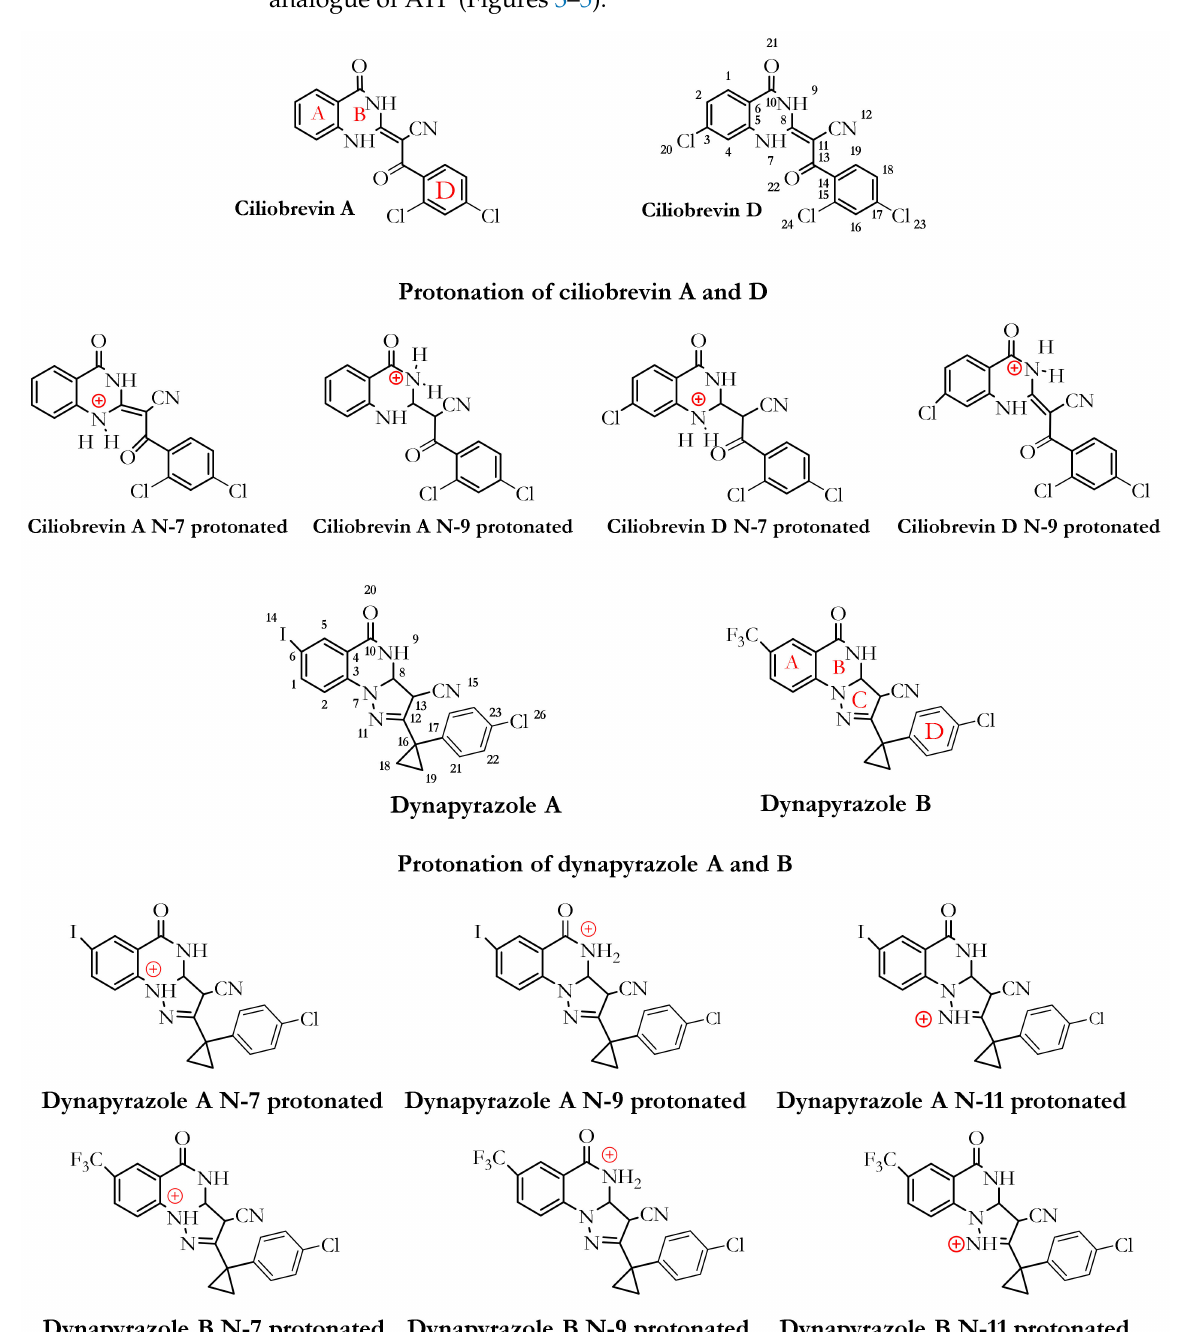
Figure 4. Chemical structures of ciliobrevin A and D, dynapyrazole A and B, and their protonated structures in the ligand library. Ciliobrevin A and D are analogues 1 and 2, respectively. Chemical structures and atom numbering were obtained utilizing Chemdraw software